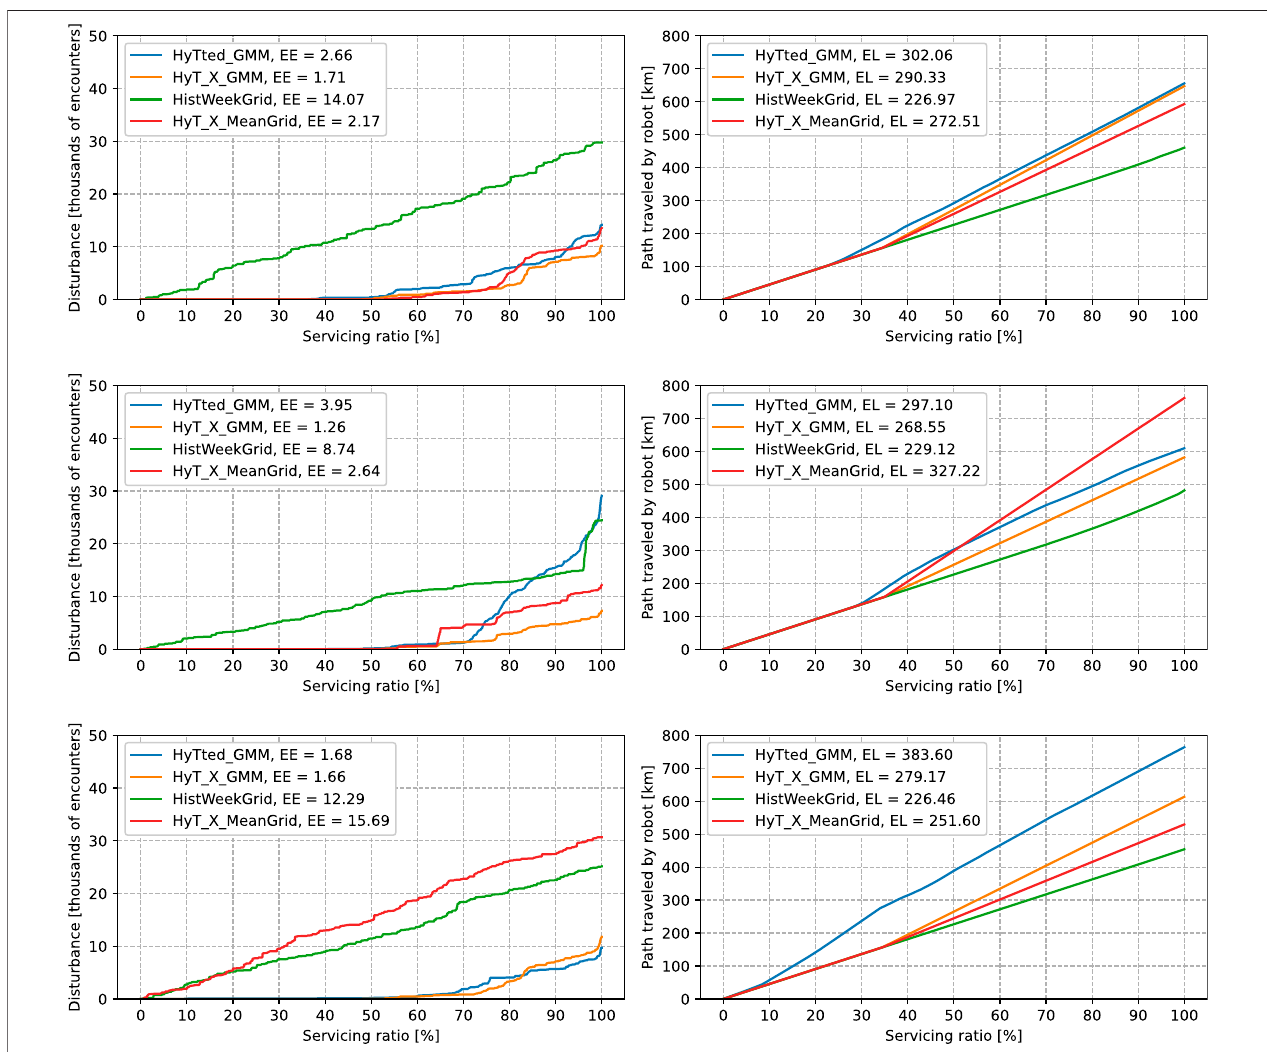
FIGURE7| Comparisonofselectedmodelsunderdifferentscenarios.Theleftcolumnsofgraphsdepictservicedisturbances,thequantilefunctionsoftheordered human – robot encounters. The right columns of graphs depict traveled distances, the quantile functions of lengths of paths. The labels in graphs consist of names of modelsandtheexpectedvalues.Firstrow:modelstrainedoverthesparse,spatio-temporaldata.Secondrow:modelstrainedoverthespatio-temporal-directionaldata. Third row: models trained over the sparse, spatio-temporal-directional data.